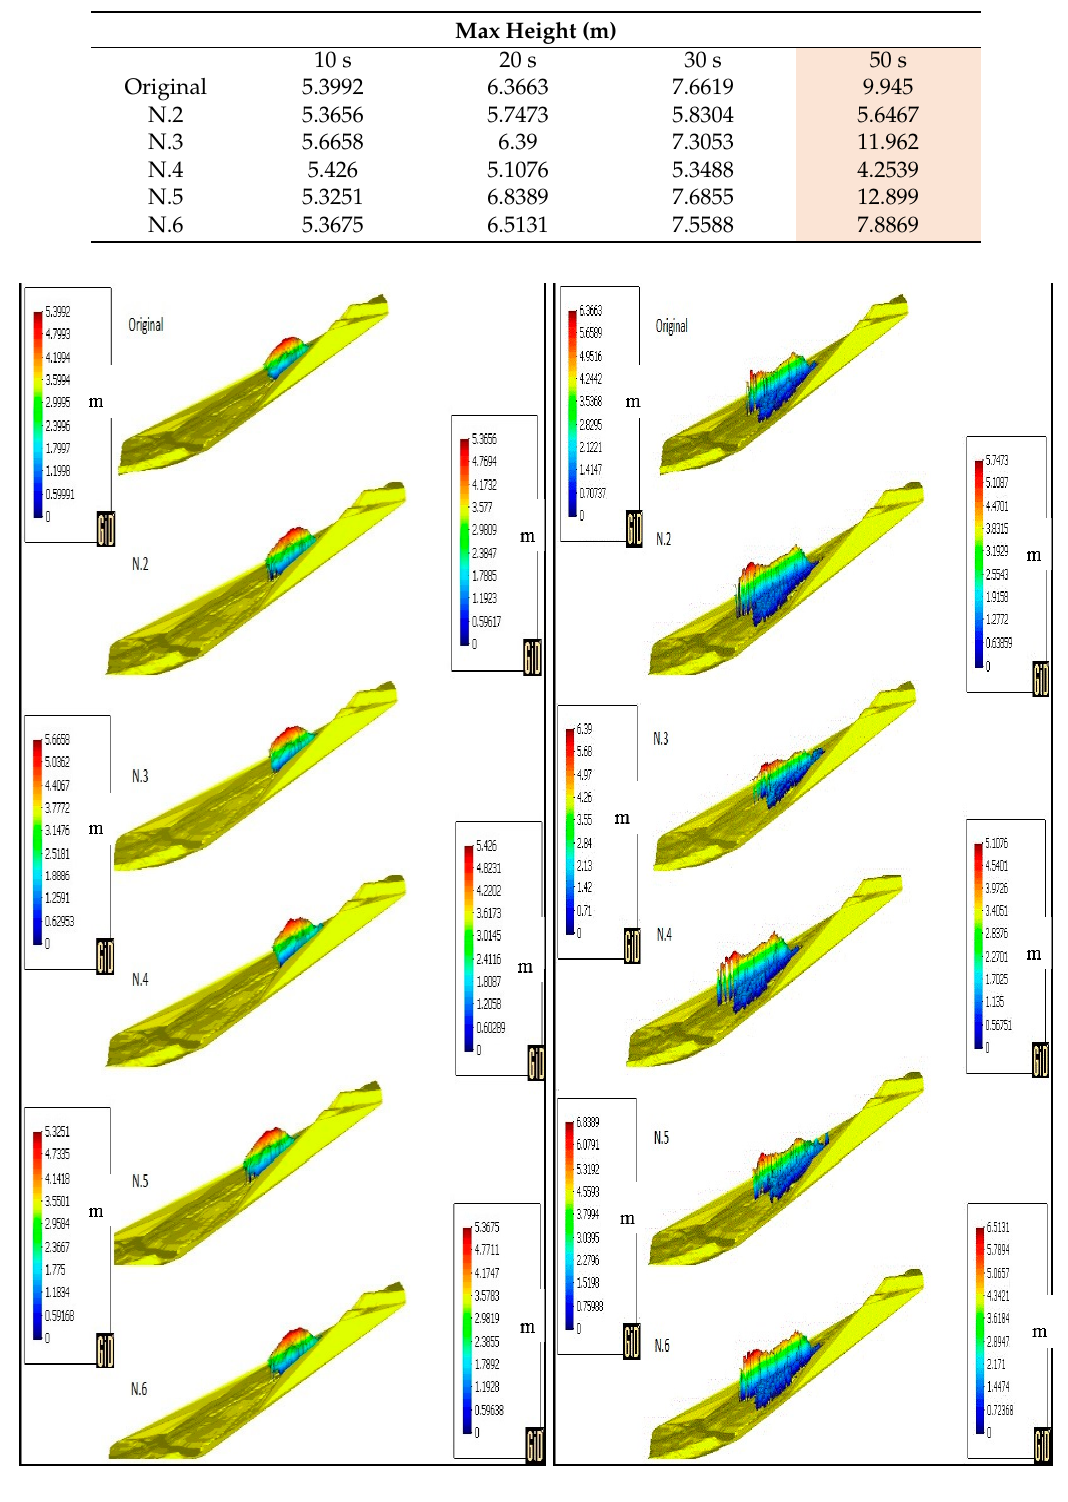
Figure 12. Height profile of the sliding mass at 10 s ( left ) and 20 s ( right ) for the simulations with the parameters in Table 3.